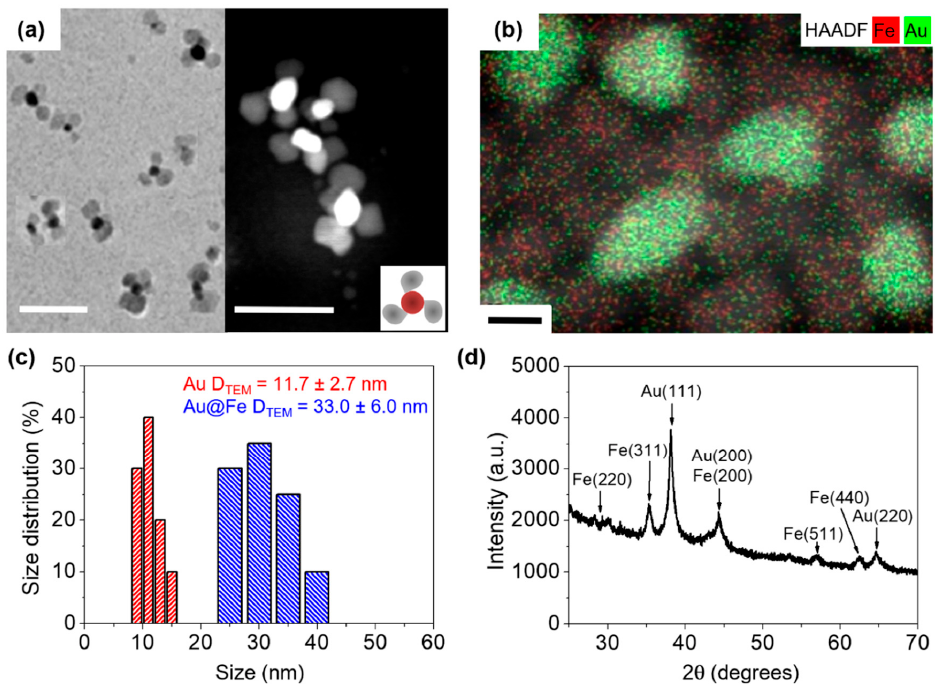
Figure 1. ( a ) Representative TEM (left) and STEM (right) images of Au@Fe NPs. The inset represents a scheme of the obtained NPs. Scale bar corresponds to 50 nm. ( b ) Spatial distribution of metal atoms in the Au@Fe NPs as measured by HAADF and EDX. Scale bar corresponds to 10 nm. ( c ) Size distribution derived from counting at least 100 NPs in TEM images of Au seeds (red) and Au@Fe NPs (gray). ( d ) X-ray powder diffraction (XRD) pattern of Au@Fe NPs. Pharmaceutics 2022 , 14 , x